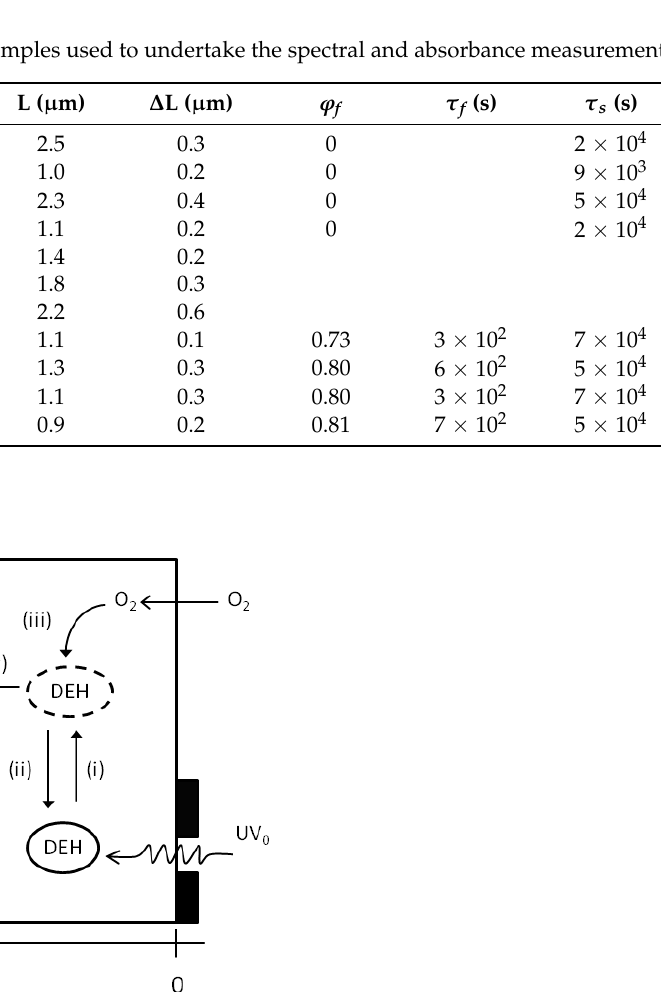
Table 1. Details of the MDP samples used to undertake the spectral and absorbance measurements. Polymer